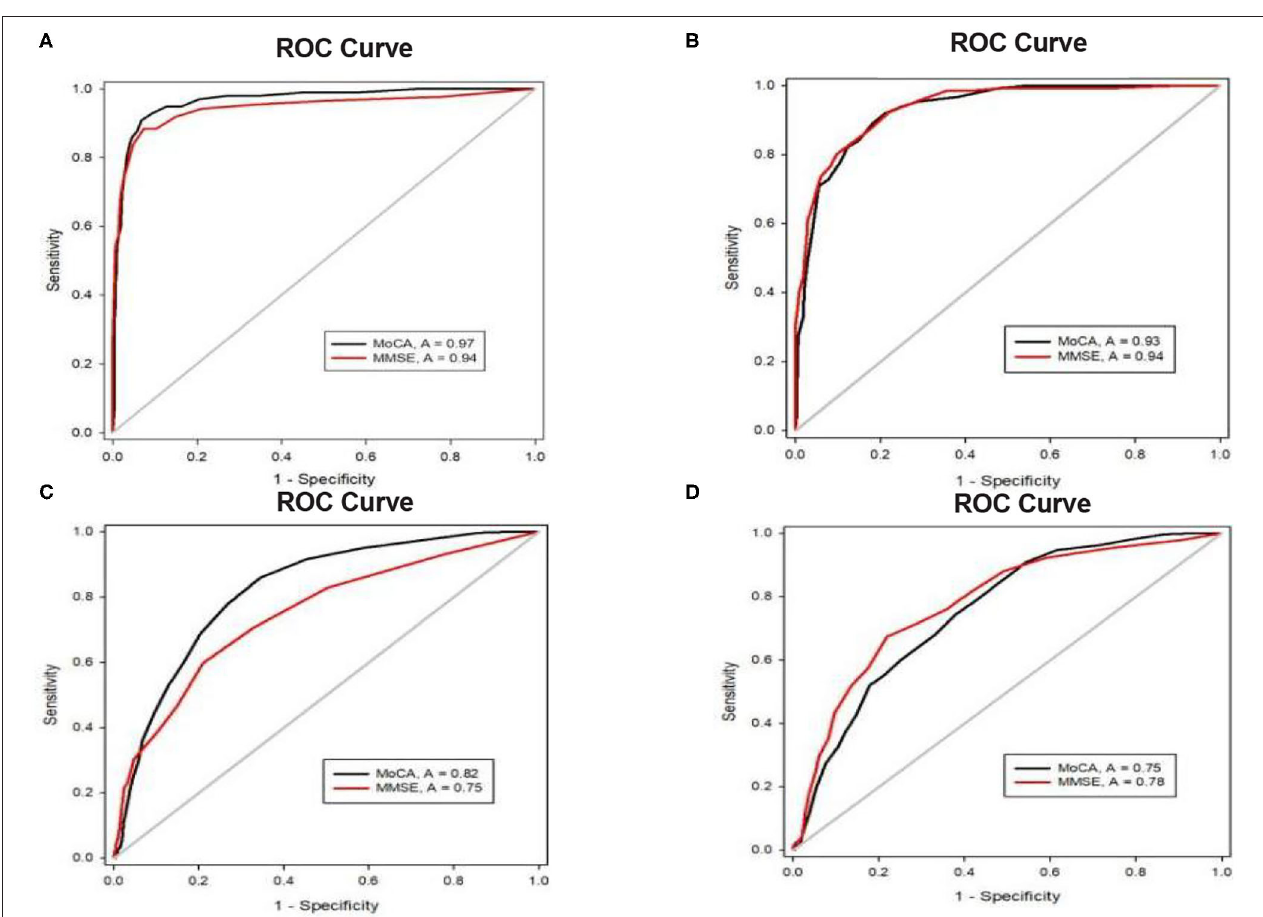
Normal vs. MCI Normal vs. Dementia